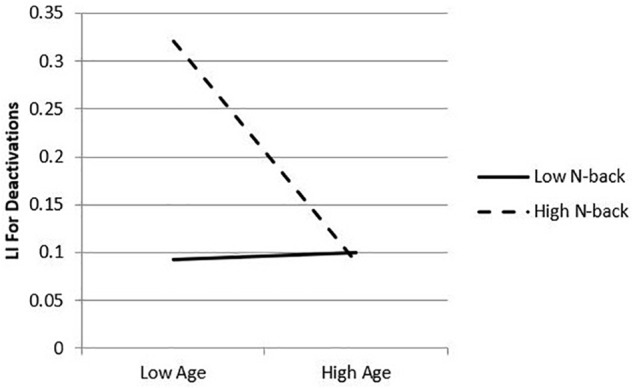
Simple slopes plot of conditional effects of 2-back. 2-back performance moderates the relation between age and laterality index. Plot represents laterality index (greater number depicts greater left lateralization) as predicted by age at fixed values of the moderator, 2-back: +1 standard deviation (11.5) and –1 standard deviation (–11.5) from the sample mean.